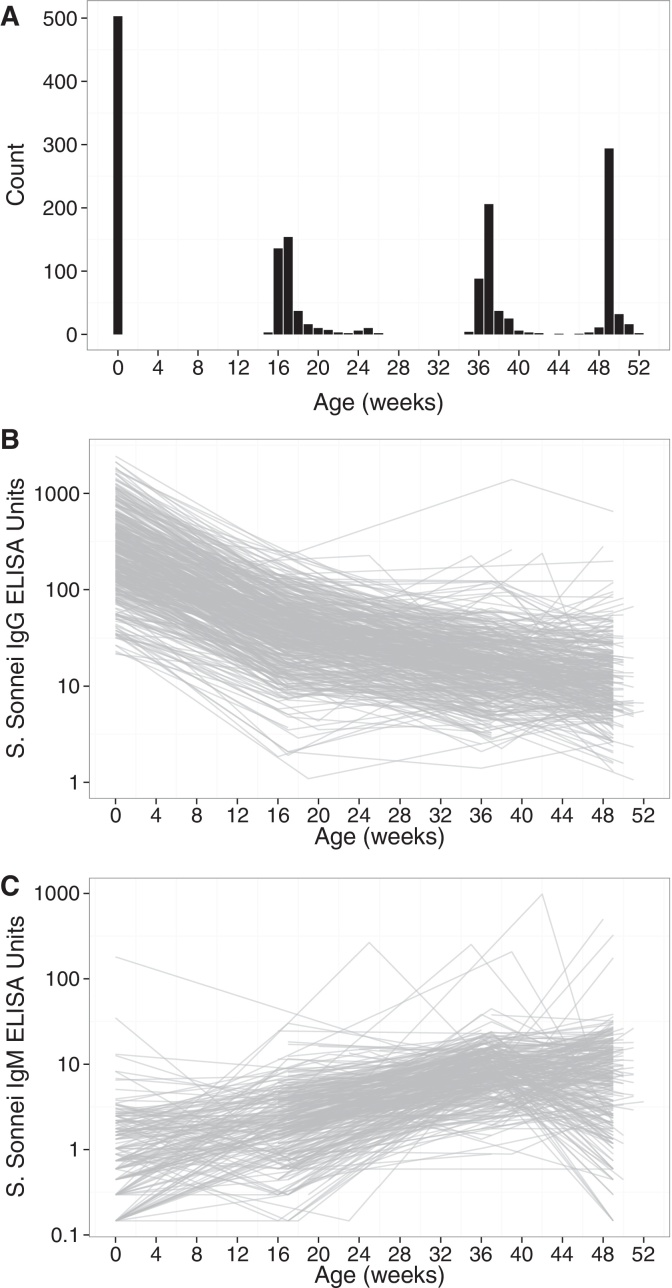
Anti-S. sonnei-O antibody levels in the first year of life in a cohort of 503 Vietnamese children. (A) Count of the number of assayed infant plasma samples at different ages in the first year after birth. Anti-S. sonnei-O IgG (B) and IgM (C) titers shown over time for each individual in the cohort on a log10 scale.